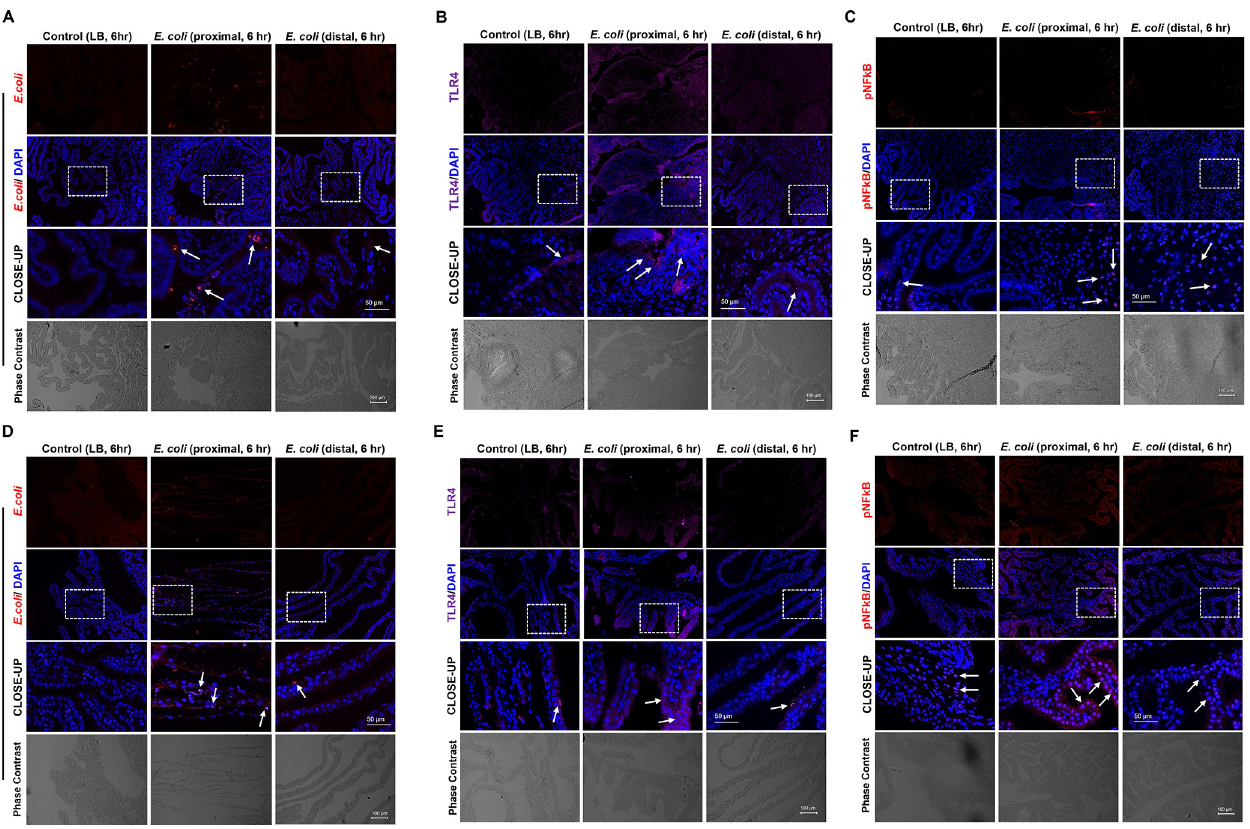
Fig 5. E . coli induced inflammatory marker stepwise progression is consistent with ascending bacterial infection in mice uterine cavity. Immunohistochemical analysis proximal and distal uterine ( A-C ) and fetal membrane tissues (D-F) collected 6 hr after vaginal administration of 10 11 CFU of E . coli (N = 3). Proximal portions of the uterine sections show higher rates of E . coli than distal portions ( A ). Inflammatory markers, TLR-4 and P-NF- κ B expressions were higher in the proximal uterine section than distal sections ( B-C ). Control uterine sections show comparable expression of the inflammatory markers (TLR-4 and P-NF- κ B) to distal sections ( B-C ). Proximal fetal membrane section shows higher rate of E . coli than distal portion ( D ). Inflammatory markers, TLR-4 and P-NFkB expressions were higher in the proximal fetal membrane section than distal sections ( E-F ), and control sections show comparable expression of the inflammatory markers (TLR-4 and P-NFkB) to distal sections ( E-F ). (Scale bar, 100 μ m). The close-up displays the enlarged tissue area marked by white boxes (Scale bar, 50 μ m).